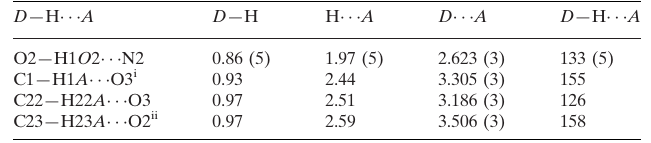
Hydrogen-bond geometry (A˚ , (cid:2)